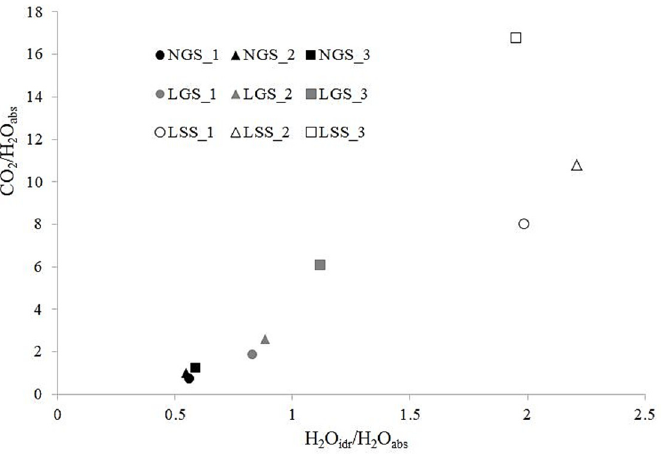
Figure 15. Correlation between carbon dioxide and hydraulic water obtained from STA.